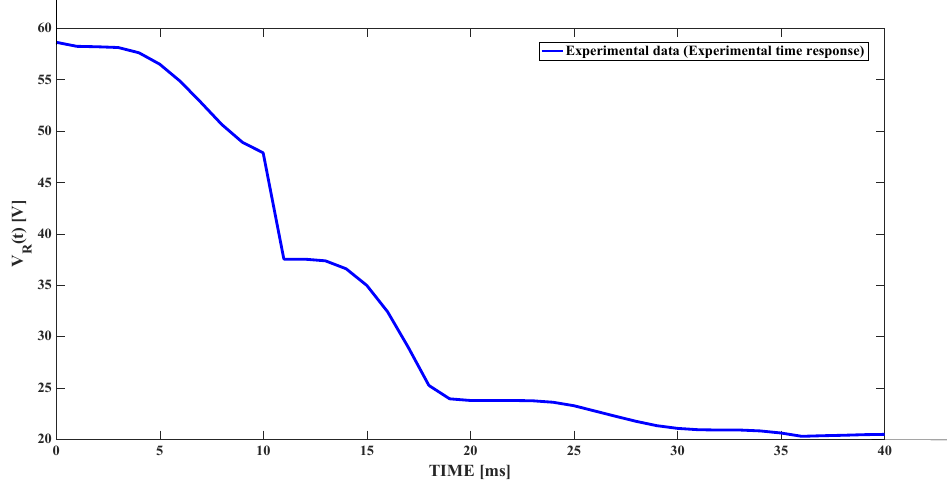
Figure 2. Experimental time response (transient fault).